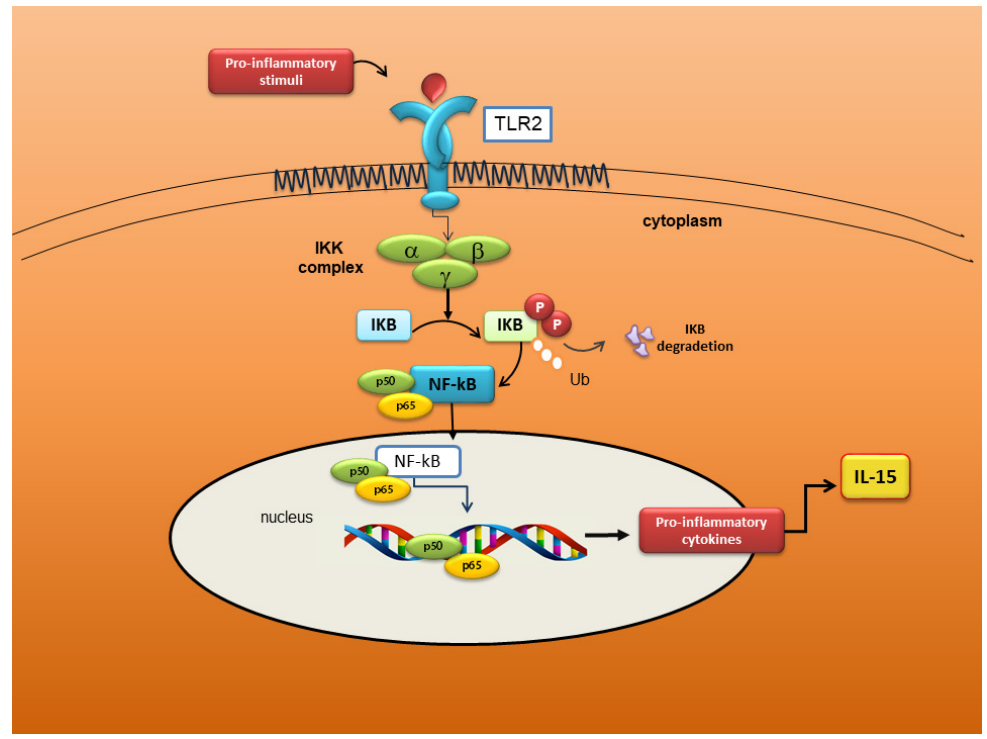
Figure 4. Schematic representation of the Toll-Like Receptor 2 (TLR2) / IL-15 / NF- κ B pathway in pSS SGEC. TLR2, in response to pro-inflammatory stimuli, activate the NF- κ B pathway; in the nucleus, the active NF- κ B promote IL-15 gene transcription; thus, incrementing inflammatory disorders in SGs of pSS